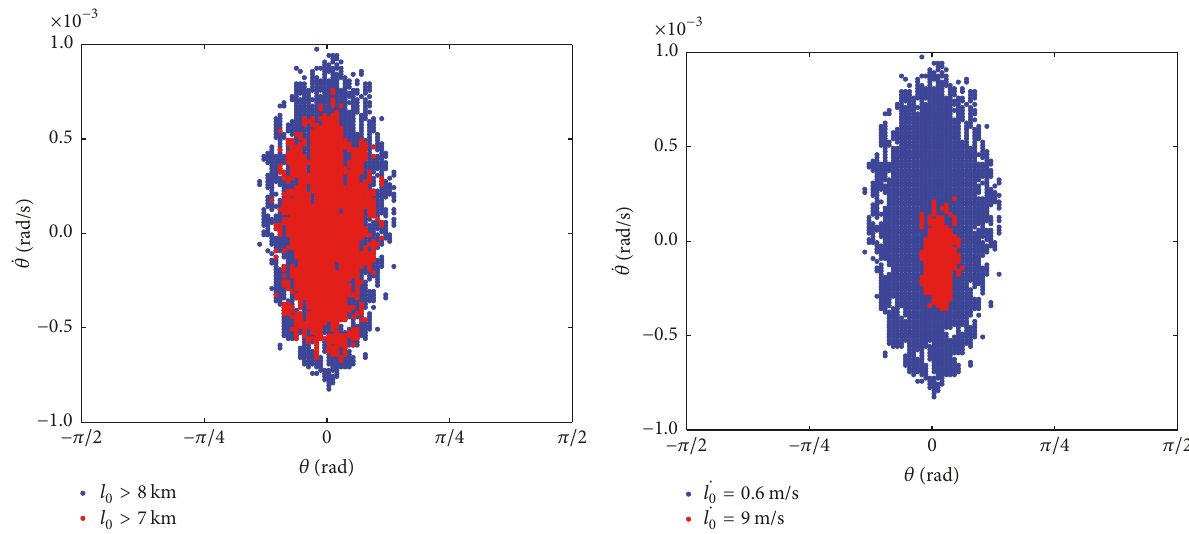
(b) Effect of initial radial velocity of subsatellite on the parameter domain ̇𝑙 < 15 m /